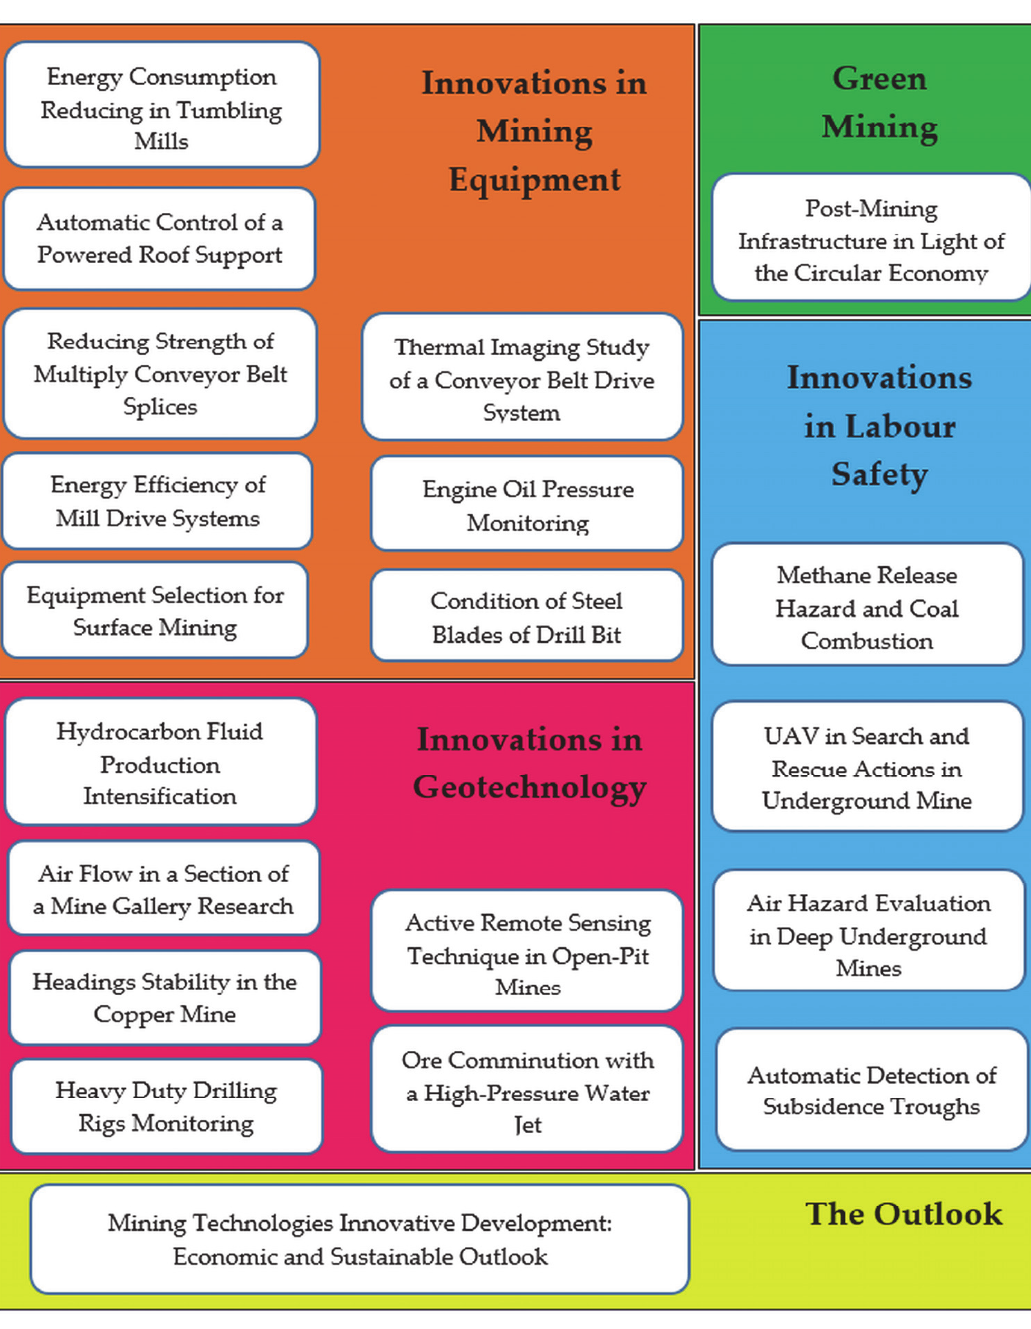
Figure 1. The spectrum of the articles published in the Special Issue “Mining Technologies Innovative Development”.